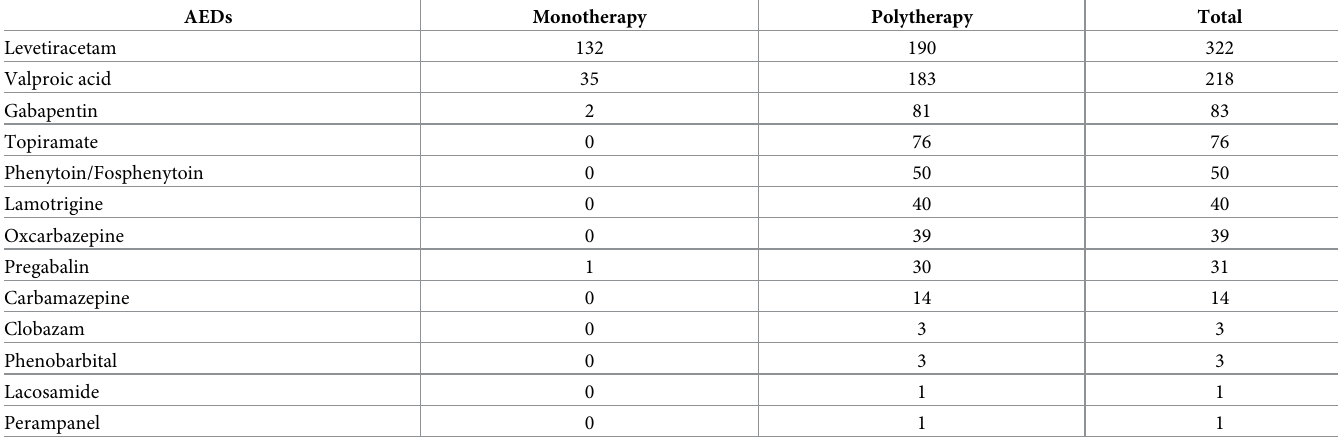
Table 2. The number of patients using